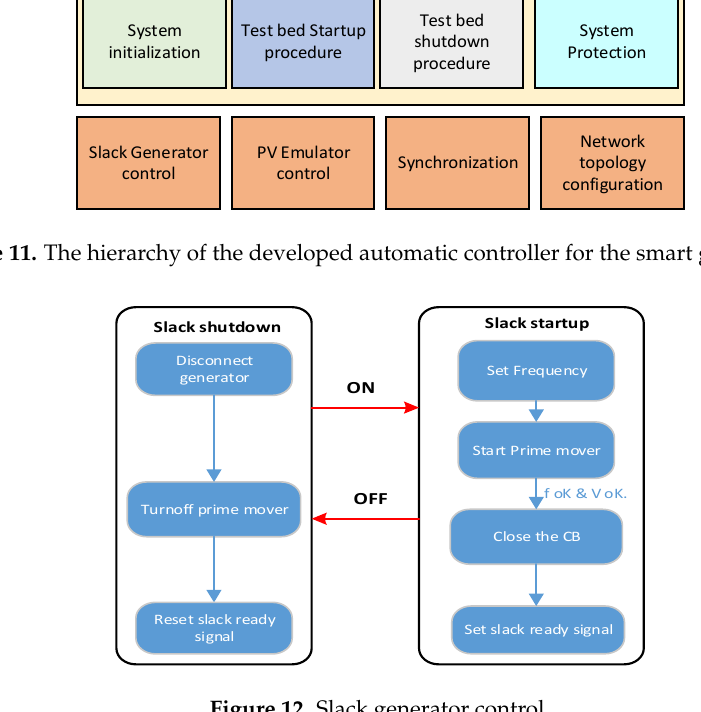
Figure 12. Slack generator control.